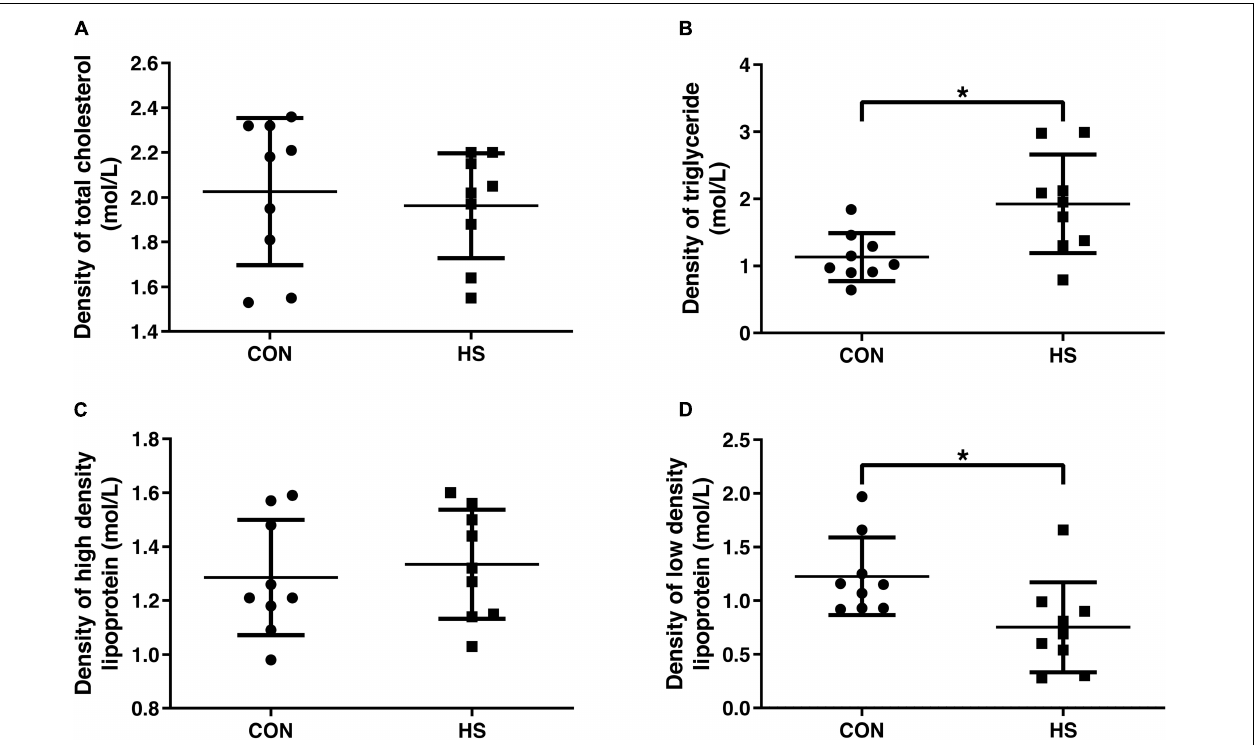
FIGURE 2 | Changes of blood lipid indicators. Density of total cholesterol (A) , triglyceride (B) , high density lipoprotein (C) and low density lipoprotein (D) in serum. CON, control group; HS, heat stress group. * P <